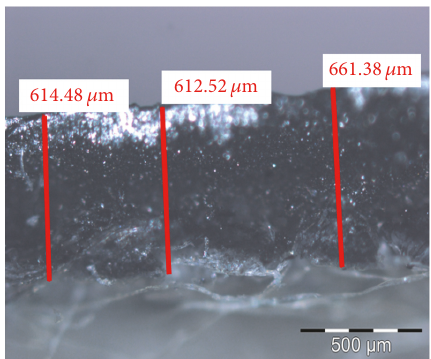
Figure 5: A cross-section of a printed antenna and its thickness.